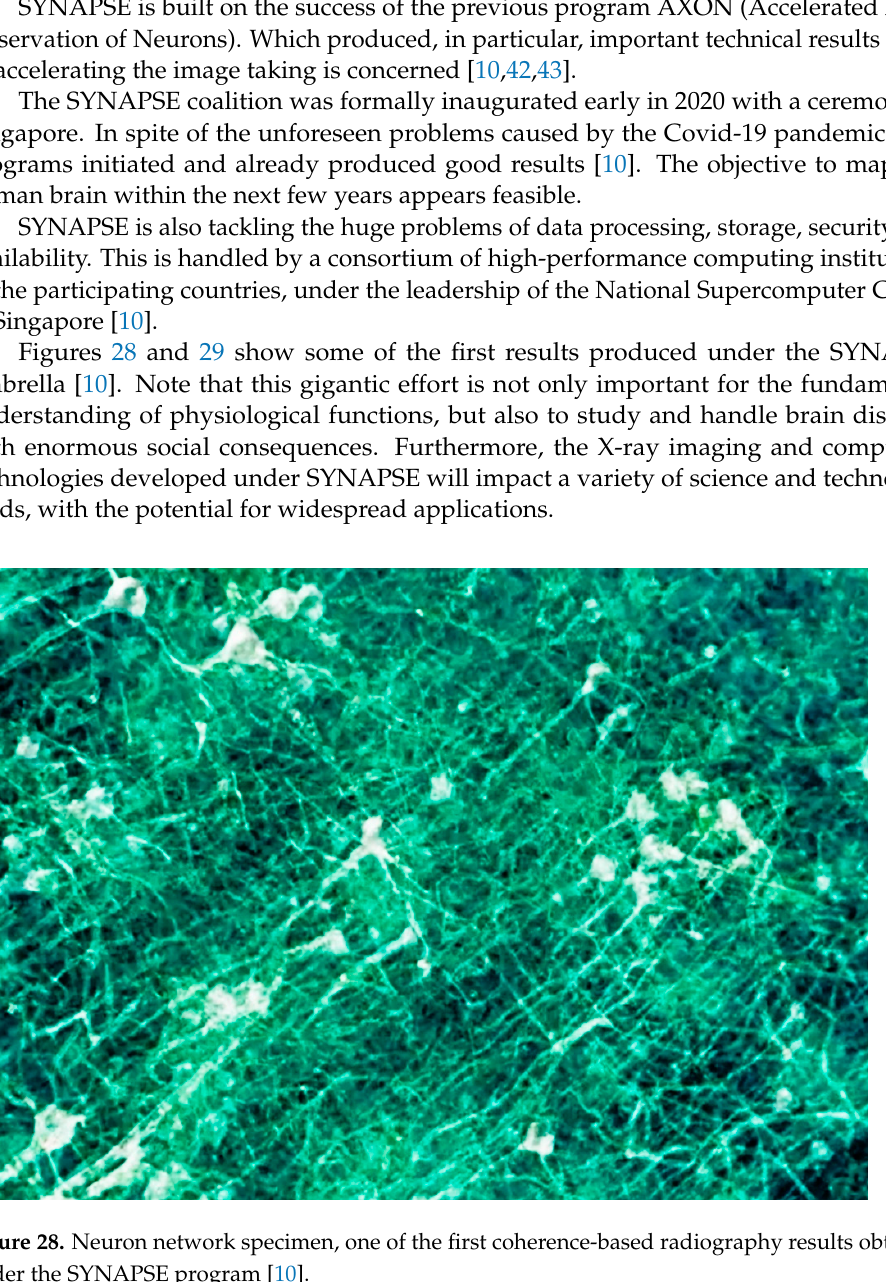
Figure 29. Another early result of SYNAPSE [10]. Author Contributions: G.M. and Y.H writing, original draft preparation, review and editing. All authors have read and agreed to the published version of the manuscript. Funding: This research was funded by EPFL; Ministry of Science and Technology, Taiwan (grant No. MOST 107-2119-M-001-047); Ministry of Science and Technology, Taiwan (grant No. MOST 106- 0210-01-15-02). Data Availability Statement: Not applicable. Conflicts of Interest: The authors declare no conflict of interest.